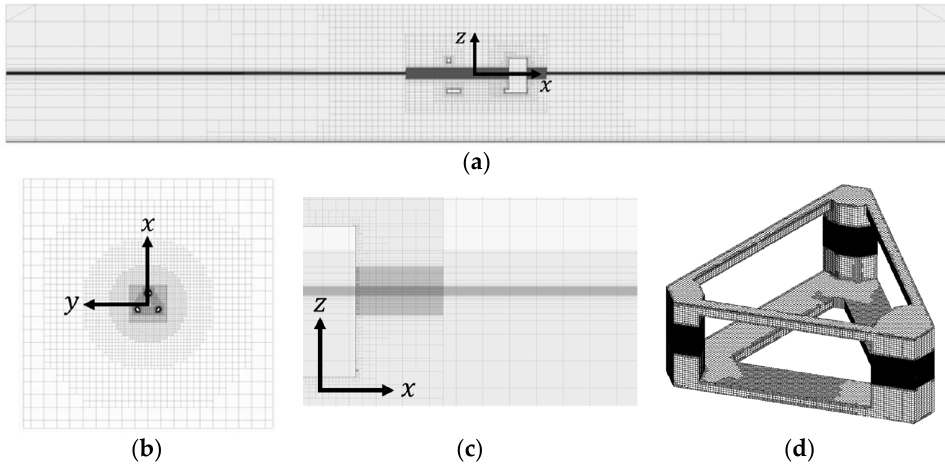
Figure A4. Mesh of viscous-flow modeling: ( a ) vertical cut at 𝑦 = 0 ; ( b ) horizontal cut at 𝑧 = 0 ; ( c ) zoomed view of horizontal cut at 𝑦 = 0 ; ( d ) surface mesh of platform.